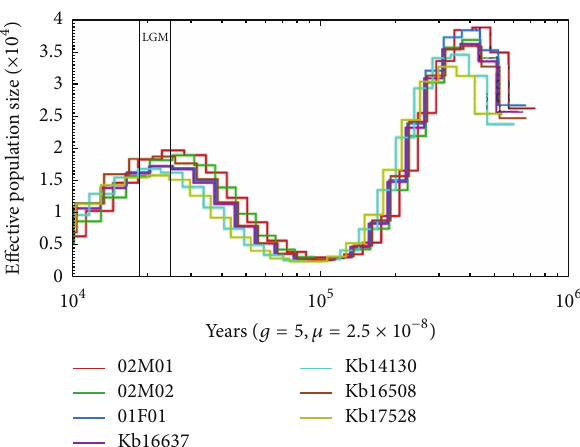
Figure 4: Estimated effective population size of Sus cebifrons based individualgenomes,generationtime(i.e.,5years),andmutationrate ( 2.5∗10 −8 ) from 10.000 (left) to 1.000.000 (right) years ago. The red and green lines indicate individuals from Rotterdam (originating from Negros island); the other individuals originated from San Diego (Panay island). A severe population bottleneck is found in all individuals around 100.000 years ago. The Last Glacial Maximum (LGM) occurred roughly 17.000 years ago (black